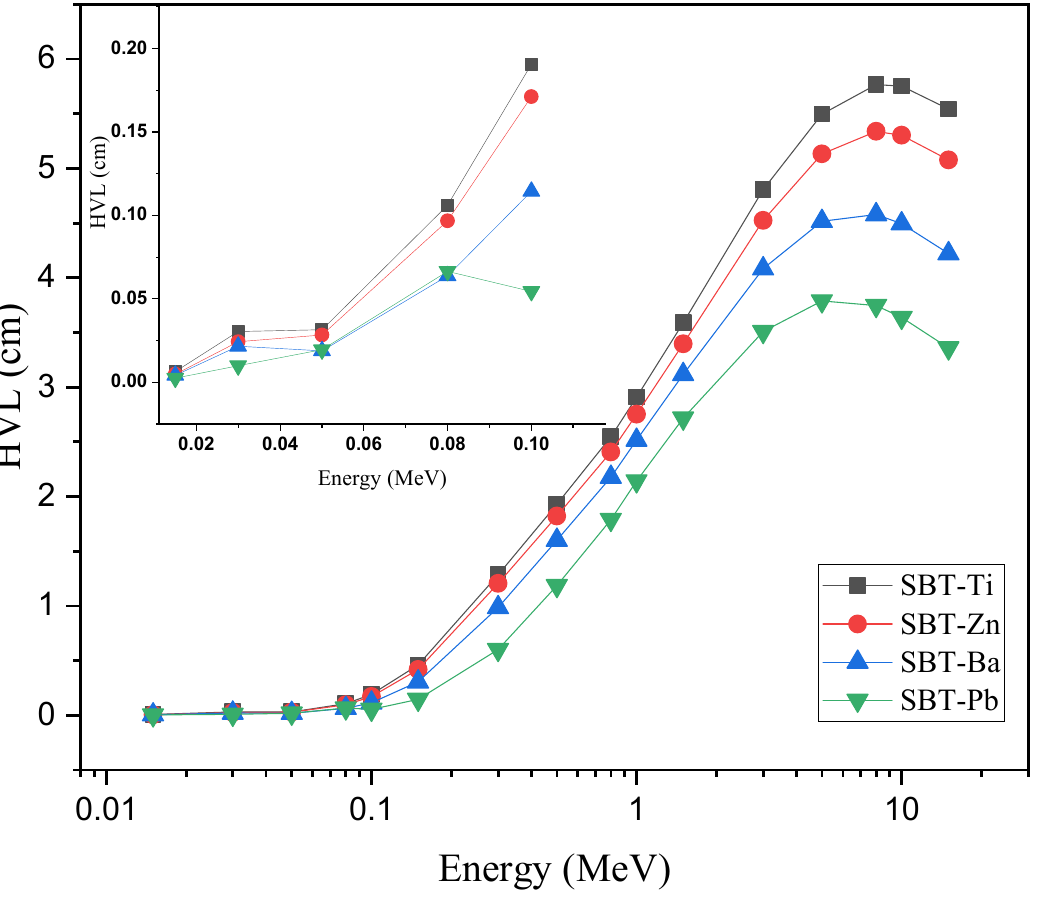
Figure 7. Variation of the half-value layer (cm) versus the gamma-ray energy for the fabricated SBT glasses. The fabricated glasses’ thickness (D eq ) equivalent to 1 cm of lead (Pb) was calculated at various energies, as presented in Figure 8. For all samples except the SBT-Pb, the D eq start very high at low energy. It takes values of 11.62, 8.81, 7.61, 4.56 cm for glasses SBT- Ti, SBT-Zn, SBTBa, and SBT-Pb, respectively. This high value of D eq is related to the high linear attenuation coefficient (LAC) of the Pb standard sample, where the LAC of the fab- ricated glasses is low compared to the LAC of Pb. After that, a sharp drop was achieved between 0.05 and 0.08 MeV. This reduction in the D eq for all samples is related to the K